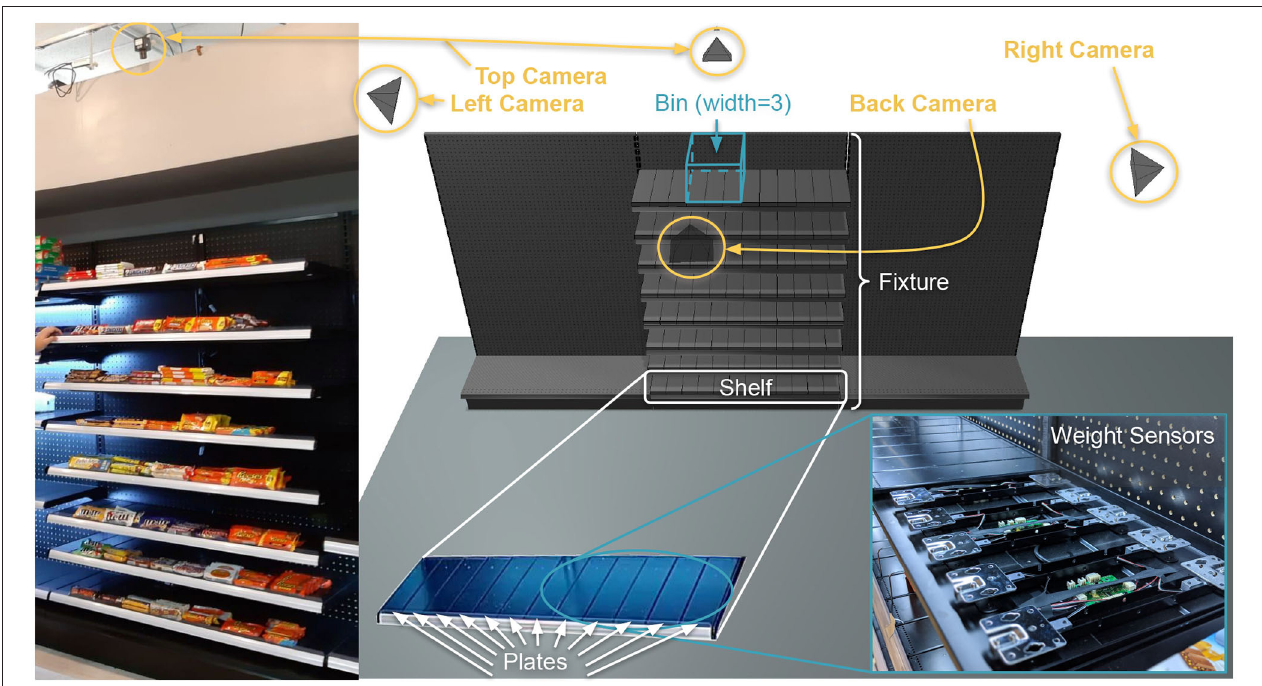
FIGURE 1 | FAIM scenario and real implementation. Through weight sensors and cameras, the goal is to autonomously detect and identify what item(s) customers